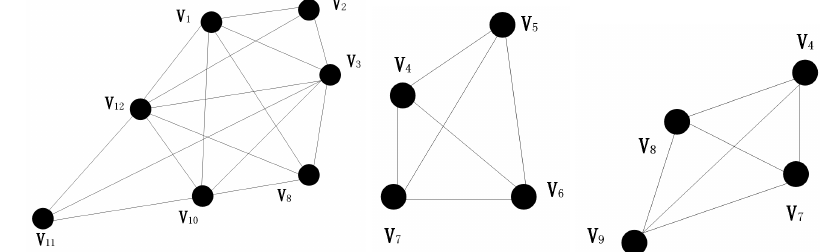
Figure 3. This picture shows the result of community division of the network structure shown in Figure